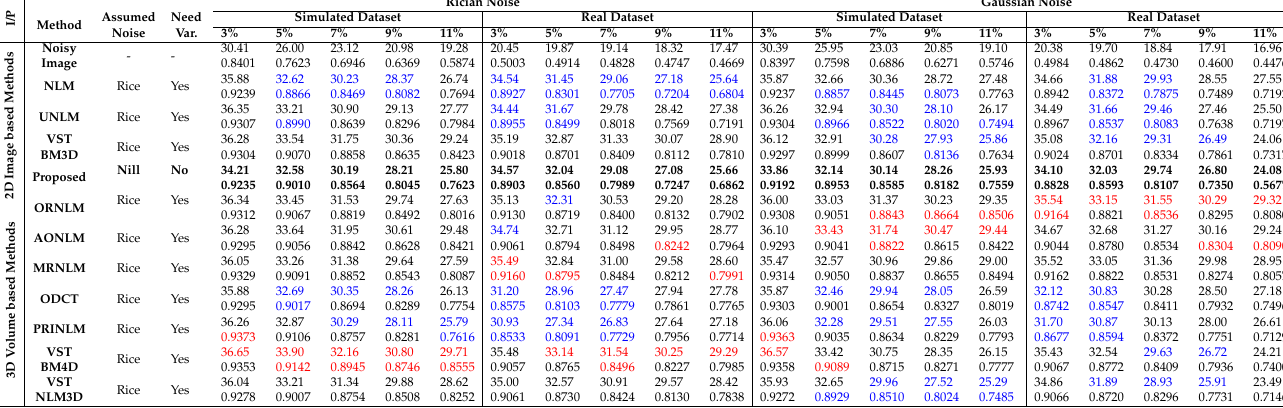
Table 1 gives the quantitative comparison of the proposed approach with existing approaches. Here, the highest PSNR and SSIM values are highlighted in red color. PSNR and SSIM values obtained for proposed work are made bold. The blue colored values indicate the performance of existing algorithms that are comparable to the proposed work.